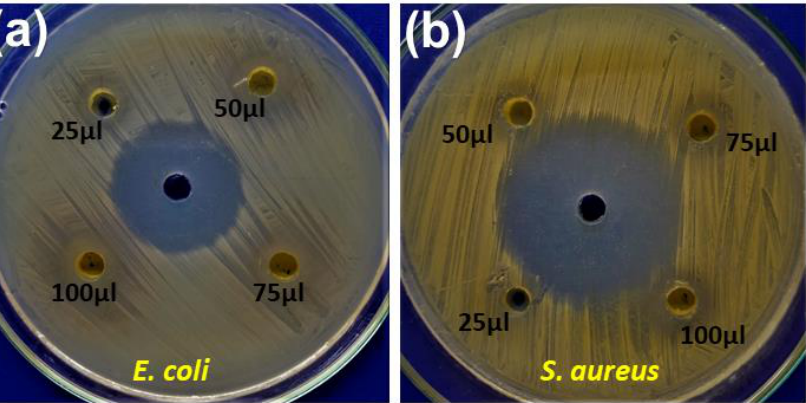
Figure 8. Bioactivity of the Se prepared with the Se 4+ /CO volume ratio of 1/2 against ( a ) E. coli and ( b ) S. aureus at the Se NPs various doses of 25, 50, 75, and 100 µL (concentration of 300 ppm).